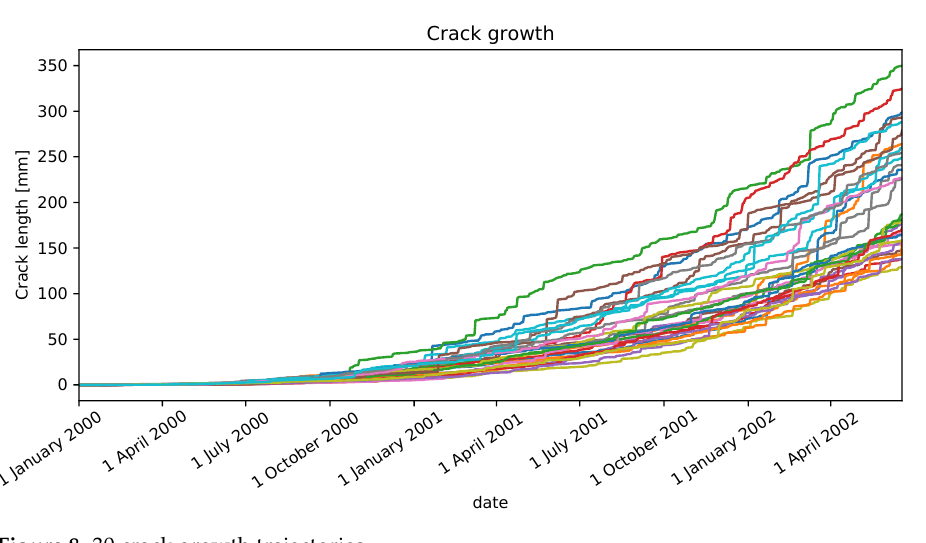
Figure 8. 30 crack growth